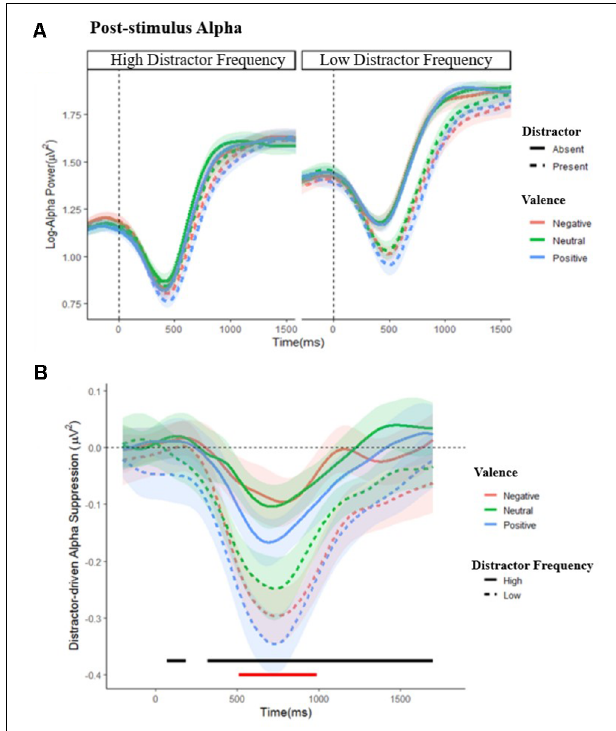
FIGURE 5 | Post-stimulus alpha power. (A) Grand average waveforms of post-stimulus alpha power in the low and high distractor frequency conditions, following either a distractor (dashed lines) or no-distractor (solid lines), appearing at 0 ms, by valence block. Stimulus onset occurs at 0 ms. (B) Distractor driven alpha suppression (calculated as Distractor Present − Distractor Absent alpha power) in the low (dashed lines) and high (solid lines) distractor frequency conditions. The black line indicates where distractor-driven alpha suppression was greater in the low compared to the high distractor frequency condition. The red line indicates where there was a main effect of valence: alpha was more suppressed following emotional compared to non-emotional distractors during this period. Shaded error bars depict the ± 95% within-subjects confidence